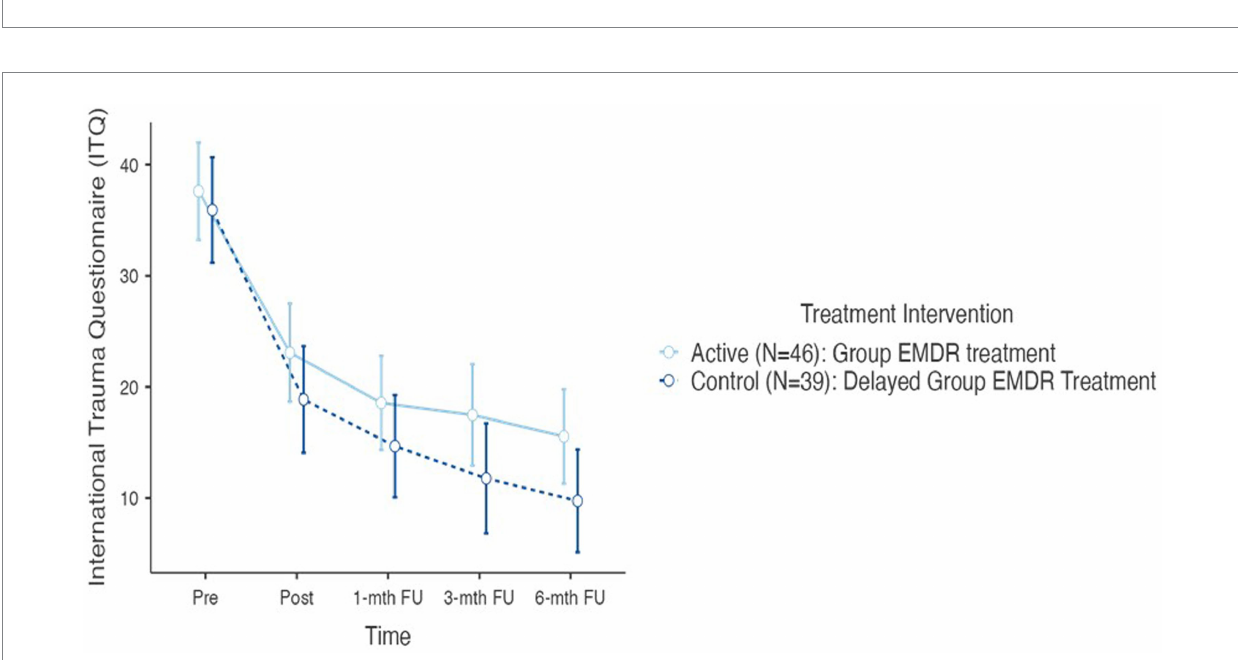
FIGURE 4 International trauma questionnaire (ITQ) T1–T5 active and control (delayed) groups ( N =85) @ p <